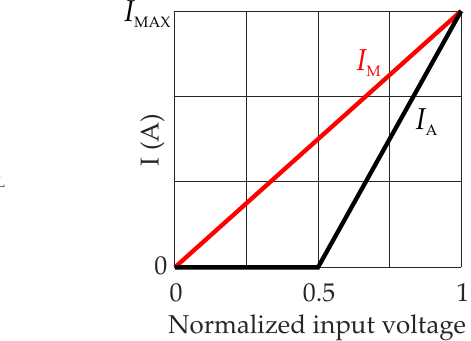
Figure 4. Schematic of the considered Doherty combiner topology ( left ) and main and auxiliary drain current profiles adopted for the analysis ( right